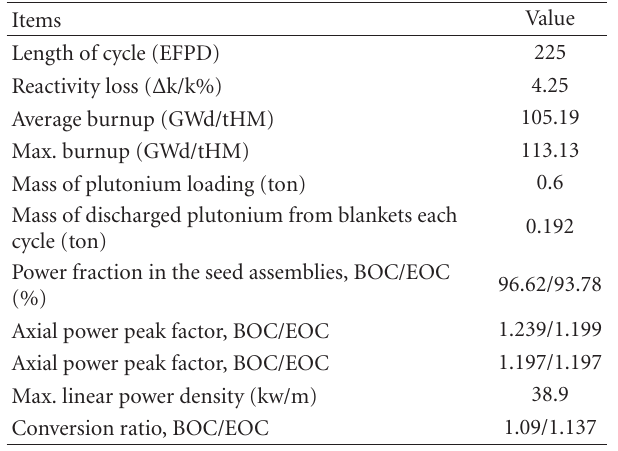
Table 3: The reactor core performance of FBR with MOX fuel